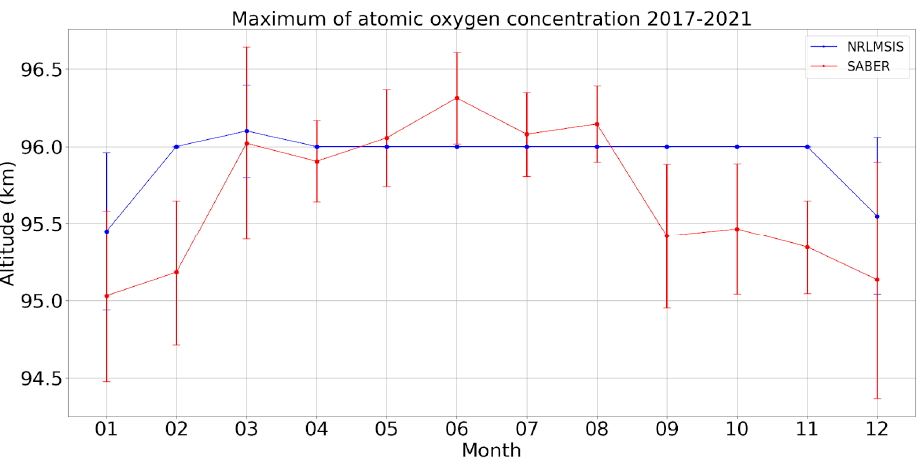
Figure 10. Monthly average altitude of maximum atomic oxygen concentration and average statistical deviations from 2017 to 2021 by SABER (red) and NRLMSIS model (blue).